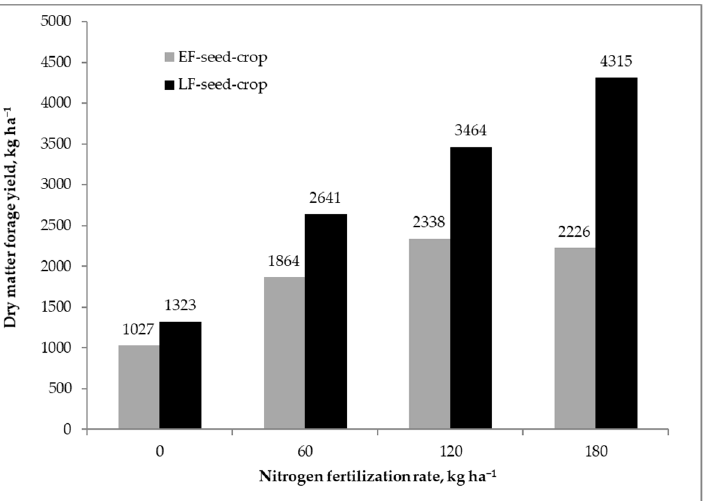
Figure 1. Effect of nitrogen fertilization on the forage yield in the dual ‐ purpose crops of Italian ryegrass at early (EF ‐ seed ‐ crop) and late (LF ‐ seed ‐ crop) spring cutting dates. LSD (0.05) = 498 kg ha − 1 for comparing means within the same management system, LSD (0.05) = 517 kg ha − 1 for comparing means within the same N fertilization, LSD (0.05) = 423 kg ha − 1 for comparing means across management system and N fertilization.